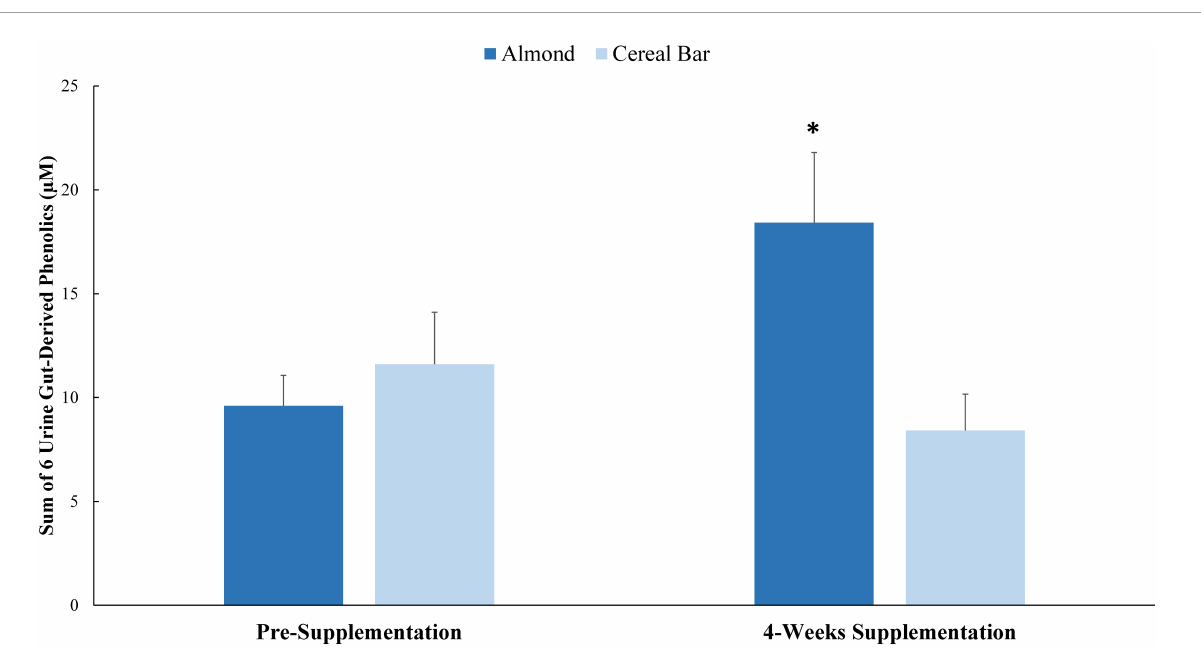
FIGURE2 Pre-study and 4-week supplementation data for the composite variable of six urine gut-derived phenolics (interaction effect p -value = 0.0013; q -value = 0.1258). ∗ Group contrast of the increase relative to pre-supplementation, P = 0.0013. Sum of: 5-(3 (cid:48) ,4 (cid:48) -Dihydroxyphenyl)- γ -valerolactone; hydroxybenzoic acid-sulfate ∗ (2 isomers of unknown structural configuration); 3-(3-hydroxyphenyl)propanoic acid-5-sulfate; benzoic acid-4-sulfate; 3-(3-hydroxyphenyl)propanoic acid-5-O-glucuronide; 3-(4-methoxyphenyl)propanoic acid-sulfate.